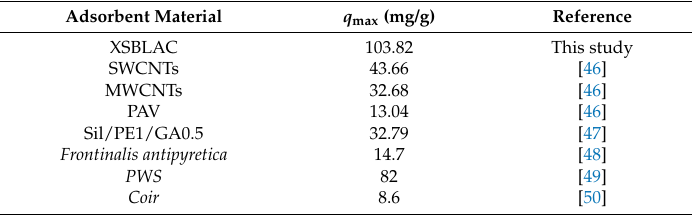
Table 6. Comparison of q max for removal of zinc(II) by various